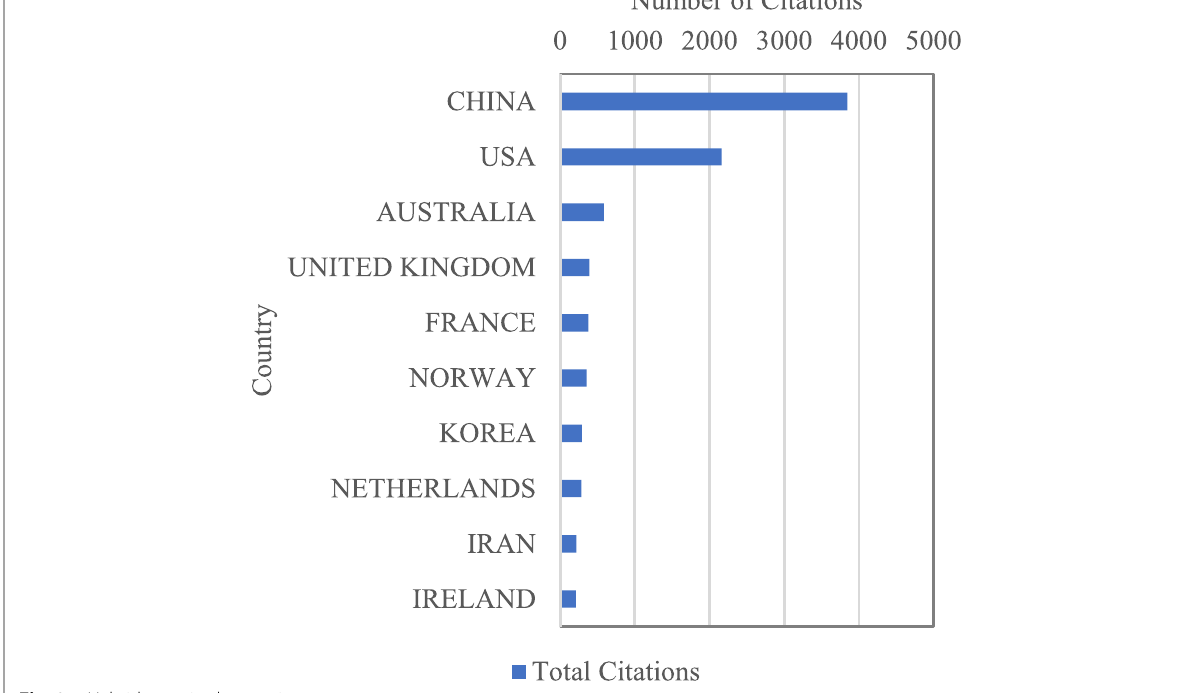
Fig. 27 Hybrid, top cited countries